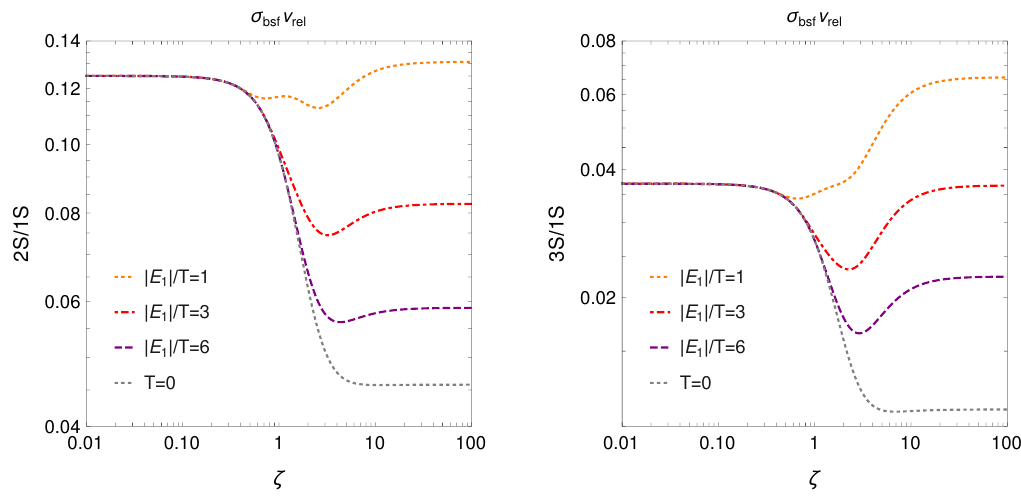
Figure 6 . The ratio σ nS v rel /σ 1 S v rel for n = 2 , 3 is shown for both the in-vacuum (gray-dotted bsf bsf line) and thermal cross sections (colored